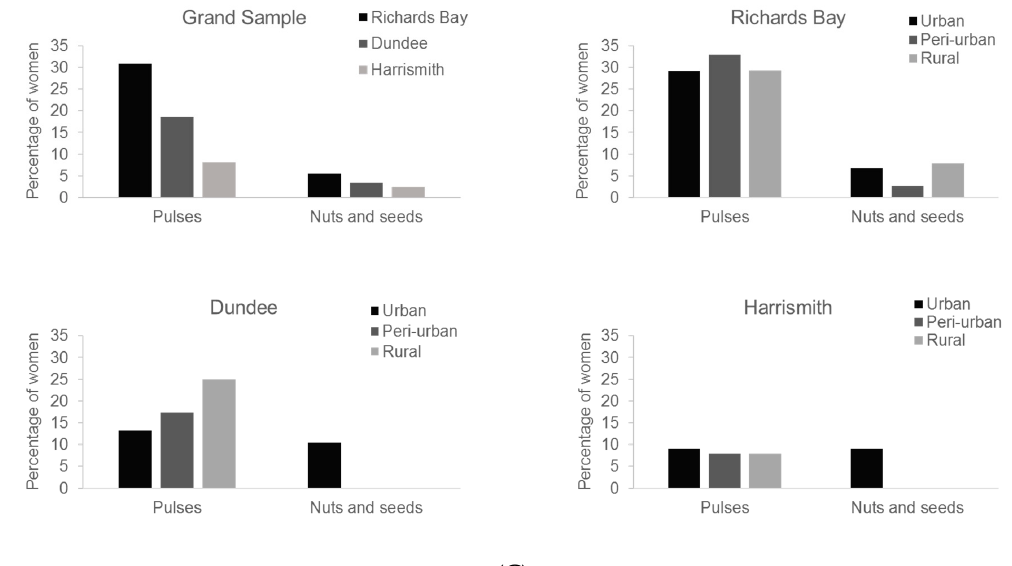
Figure 4. ( A – C ) Percentage of women consuming nutrient-rich foods in the previous 48 h along the agro-ecological gradient and rural-urban continuum. ( A ) Animal-source foods; ( B ) Fruits and vegetables; ( C ) Pulses, nuts, and seeds.